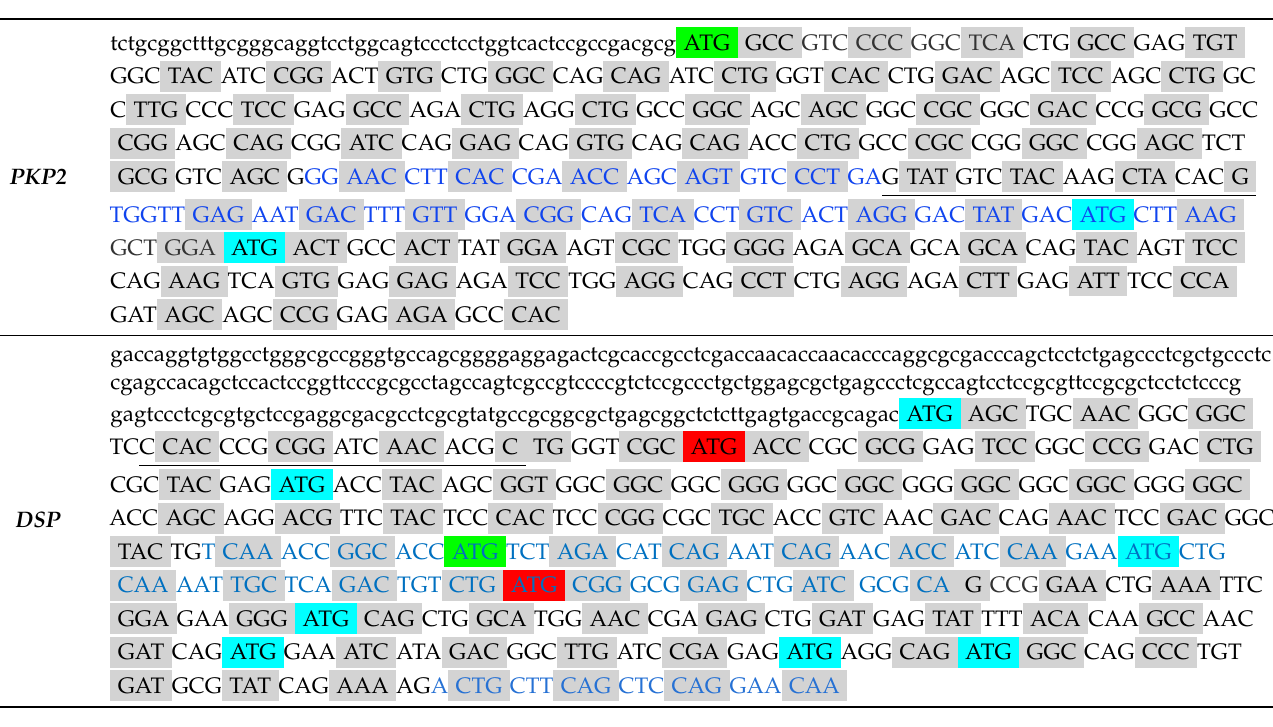
Table 2. Sequences of 5′ UTR (lowercase) and the first 160 codons (alternating white and grey; 480 base pairs) of 5 desmosomal mouse genes. Exons are shown in alternating black and blue text. The underlined sequence is the hybridisation region of sgRNA used to edit desmosomal genes in the HL1 cell line by CRISPR/Cas9. ATG codons in-frame are in green, blue or red depending on genomic context for translation reinitiation. ATGs with high optimal context (ANNATGN, GNNATGG) are highlighted in green, moderate context (CNNATGG, UNNATGG, GNNATGH) in blue and weak context (YNNAUGH) in red, where Y = C or U, H = not G (http://wwwmgs.bionet.nsc.ru/AUGWeb/ ; accessed on 24 September 2021) [25] .